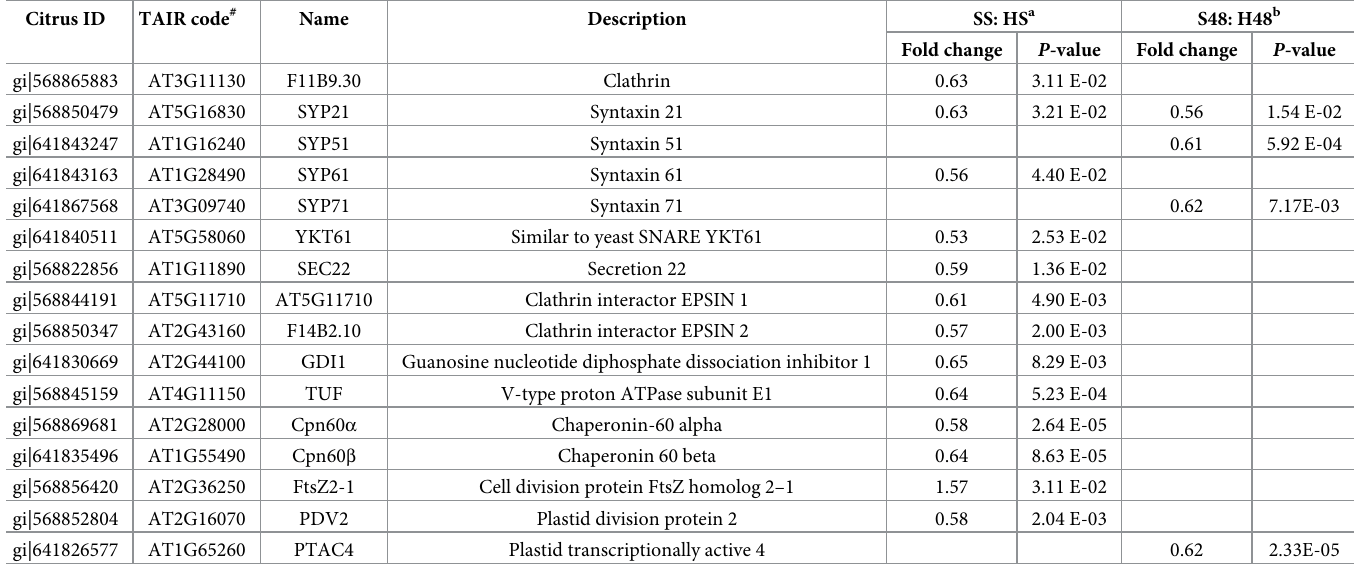
Table 3. Differentially-regulated fruit proteins in vesicle trafficking responding to Huanglongbing (HLB). Citrus ID TAIR code